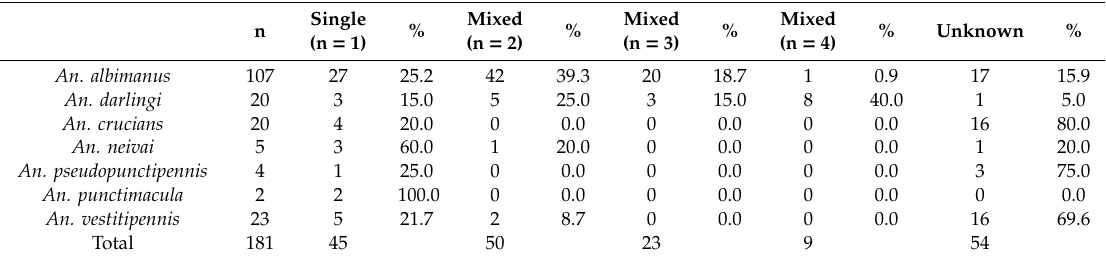
Table 3. Number of single-host blood meals, mixed blood meals and blood meals of unknown origin from seven anopheline